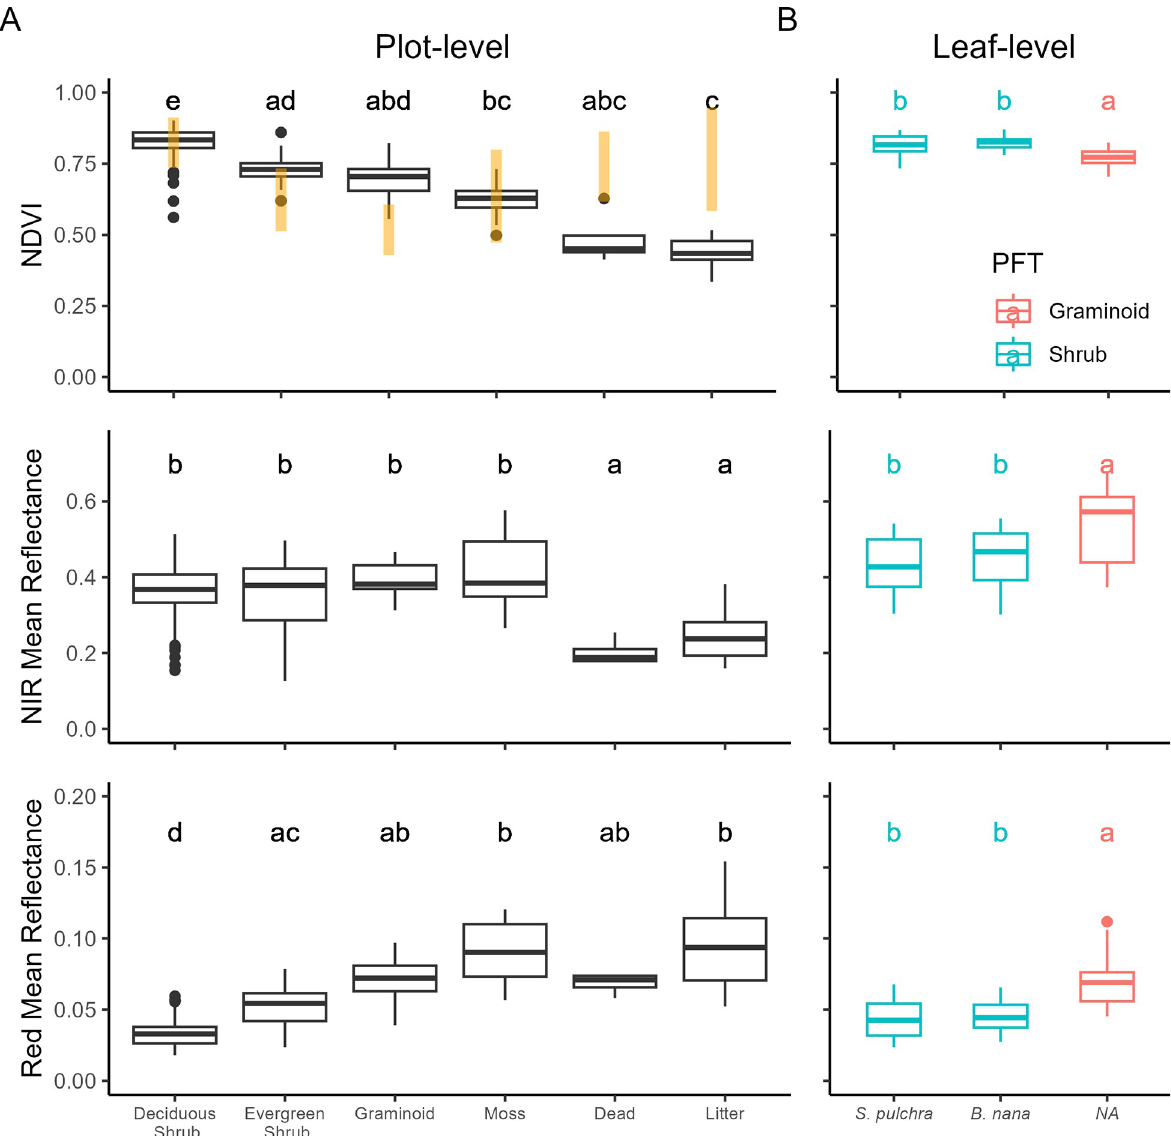
Fig 4. Reflectance signatures of CT-specific monotypic plots (A) and leaves from focal species (B). Significant differences among CTs or taxa (Dunn’s post-hoc test) in (A) and (B) are indicated by different letters. Orange bars in top left panel indicate regression coefficients (estimate ± se) from a multiple linear regression between CT top cover in the MAT sample plots and plot-level NDVI. The congruence between regression coefficients for the dominant CT’s and reflectance values from the monotypic plots supports our assertion that NDVI in mixed plots can be approximated as linear combinations of the product of CT top cover